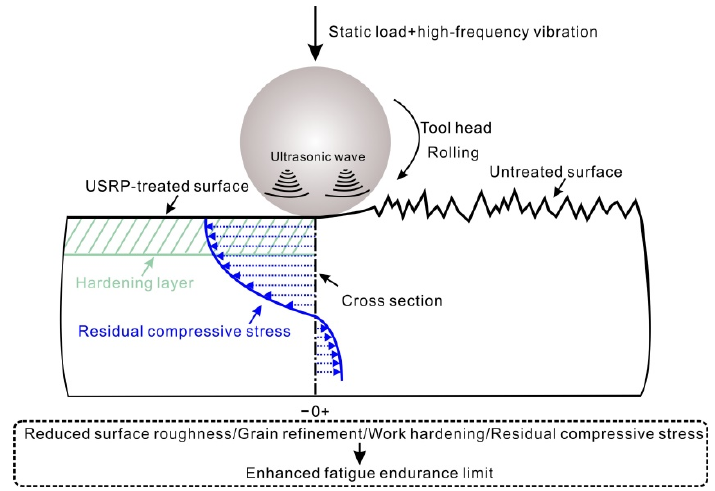
Figure 8. Schematic illustration of plastic deformation after USRP treatment.